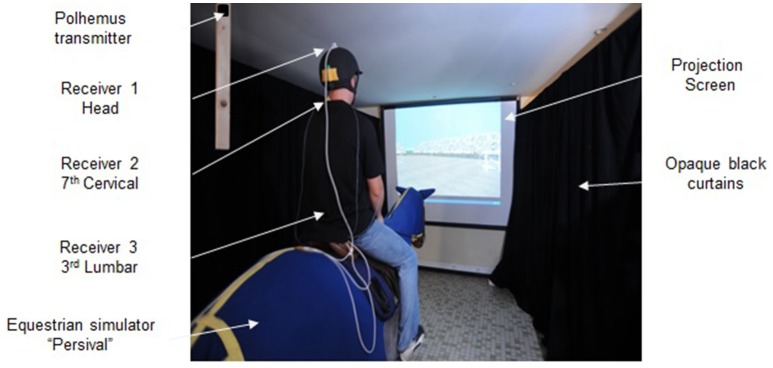
Experimental set-up.